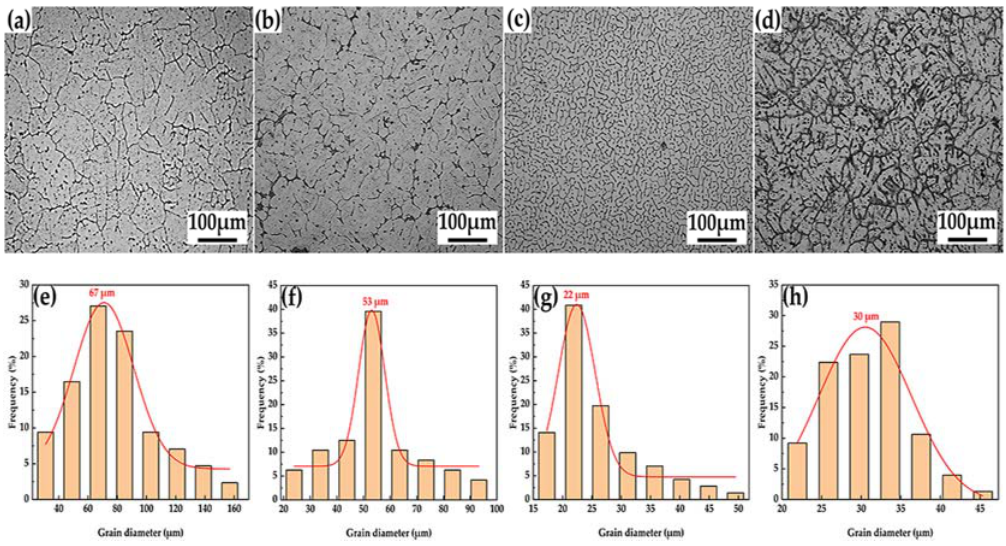
Figure 8. Microstructures of the composites with different particle contents: ( a ) matrix 6063 aluminum alloy, ( b ) 1.2 wt.%, ( c ) 2.3 wt.%, and ( d ) 3.5 wt.%. ( e – h ) Grain size distribution.